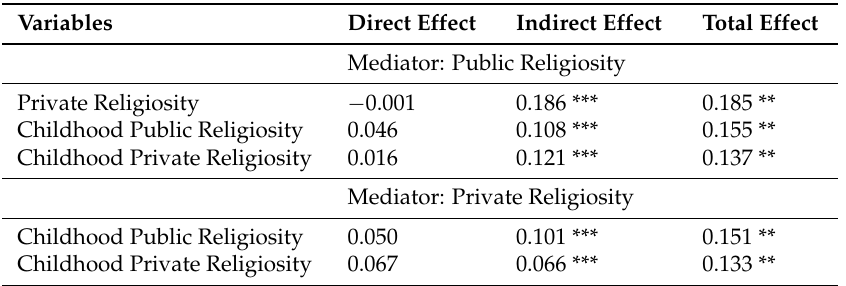
Table 4. Path analysis of mediation effects using